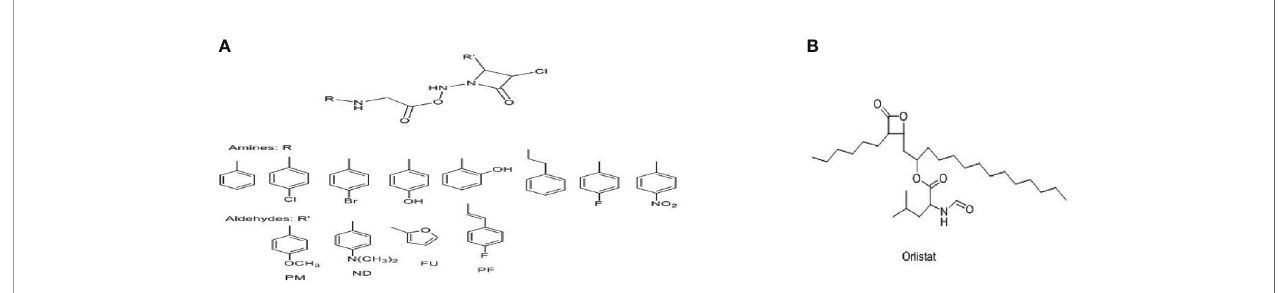
FIGURE 14 | (A) Scheme of designed molecule (B) Structure of orlistat.